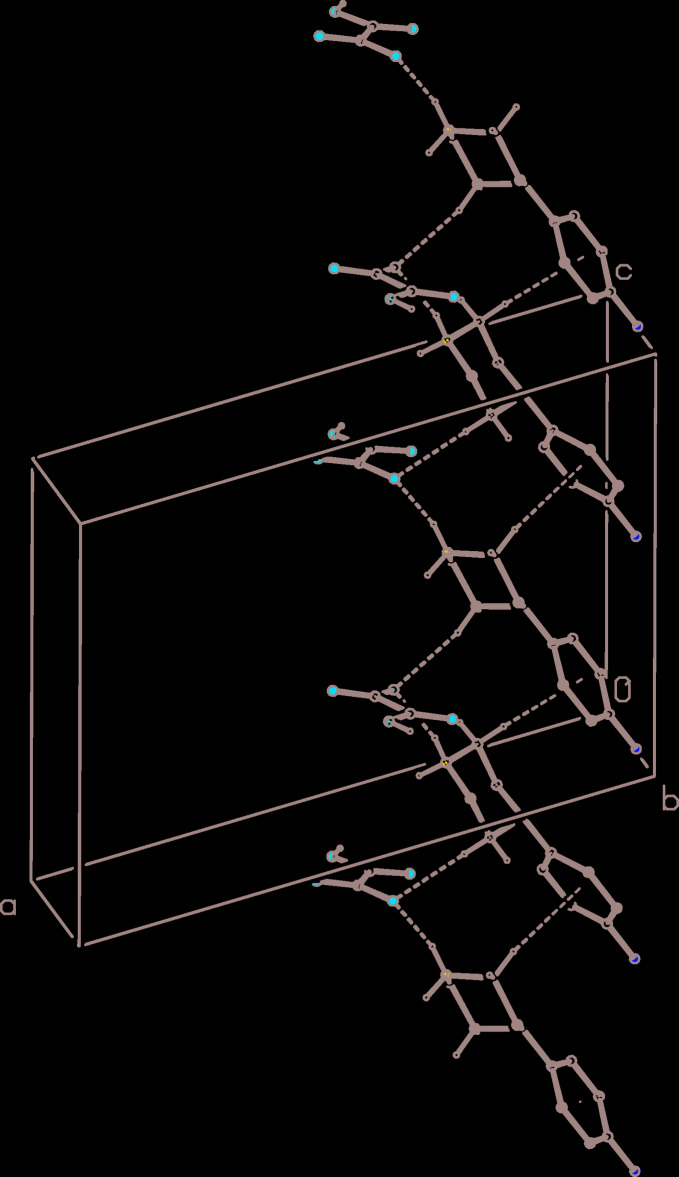
Part of the crystal structure of compound (II) showing the formation of a chain of rings running parallel to the [001] direction and built from C—H⋯O and C—H⋯π(arene) hydrogen bonds. Hydrogen bonds are drawn as dashed lines and, for the sake of clarity, the H atoms bonded to the C atoms not involved in the motif shown have been omitted.